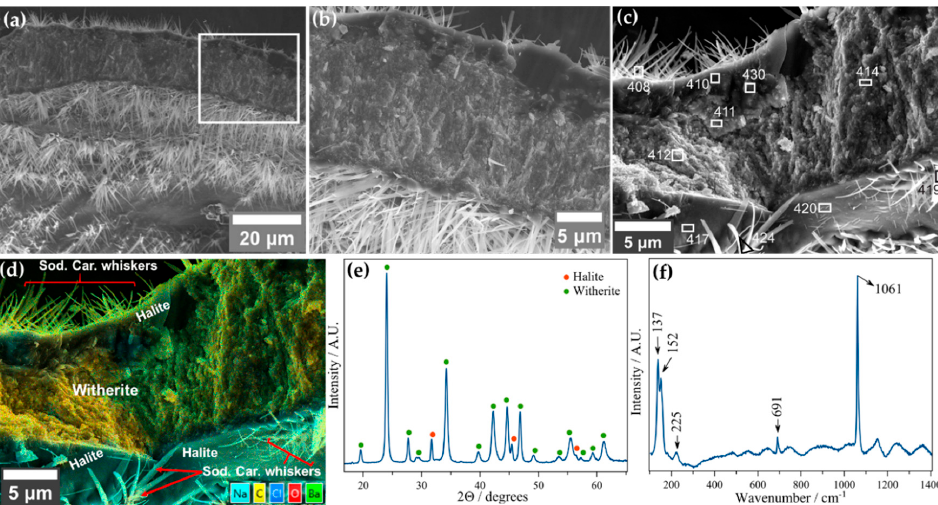
Figure 8. ( a ) Cross-section and the inner surface of Ba vesicle; ( b ) closer look of the cross-section marked by the white square in panel ( a ); ( c ) SEM micrograph of the membrane cross-section with rectangles where EDX analyses performed (see Figure S7 for EDX analyses); ( d ) EDX map of panel ( c ) showing witherite membrane with the inner and outer halite and sodium carbonate whiskers; ( e ) powder X-ray diffractogram of Ba vesicles; ( f ) Raman spectra of Ba vesicles (137, 152, 225 cm − 1 —lattice modes; 691 cm − 1 —symmetric bending mode; 1061 cm − 1 —symmetric stretching mode).